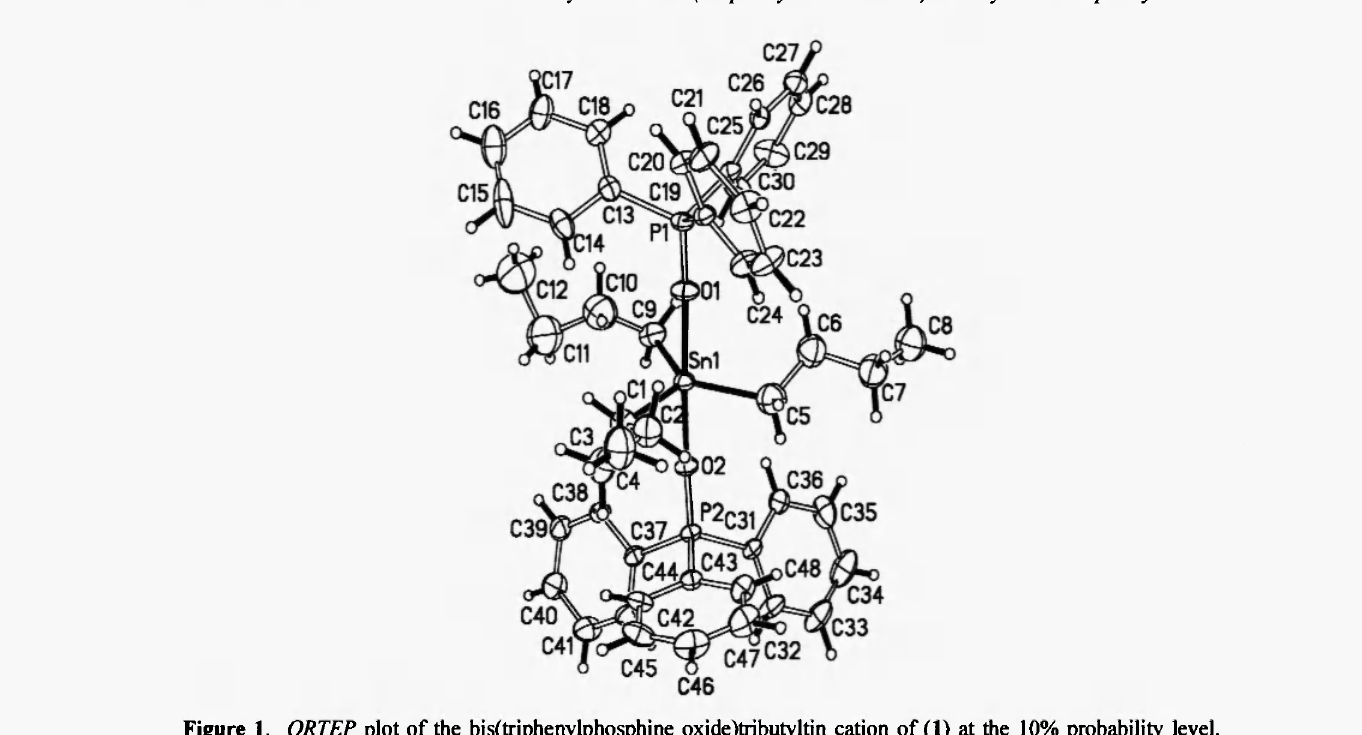
Figure 1. ORTEP plot of the bis(triphenylphosphine oxide)tributyltin cation of (1) at the 10% probability level. Selected bond distances and angles: Snl-Cl = 2.11(1), Snl-C5 = 2.11(1), Snl-C9 = 2.19(1), Snl-01 = 2.249(6), Snl-02 = 2.278(5), Pl-Ol = 1.501(6), P2-02 = 1.486(5) A; Cl-Snl-C5 = 116.8(5), Cl-Snl-C9 = 118.4(5), Cl- Snl-Ol = 90.8(4), Cl-Snl-02 = 92.2(4), C5-Snl-C9 = 124.4(6), C5-Snl-01 = 92.6(5), C5-Snl-02 = 86.1(5), C9-